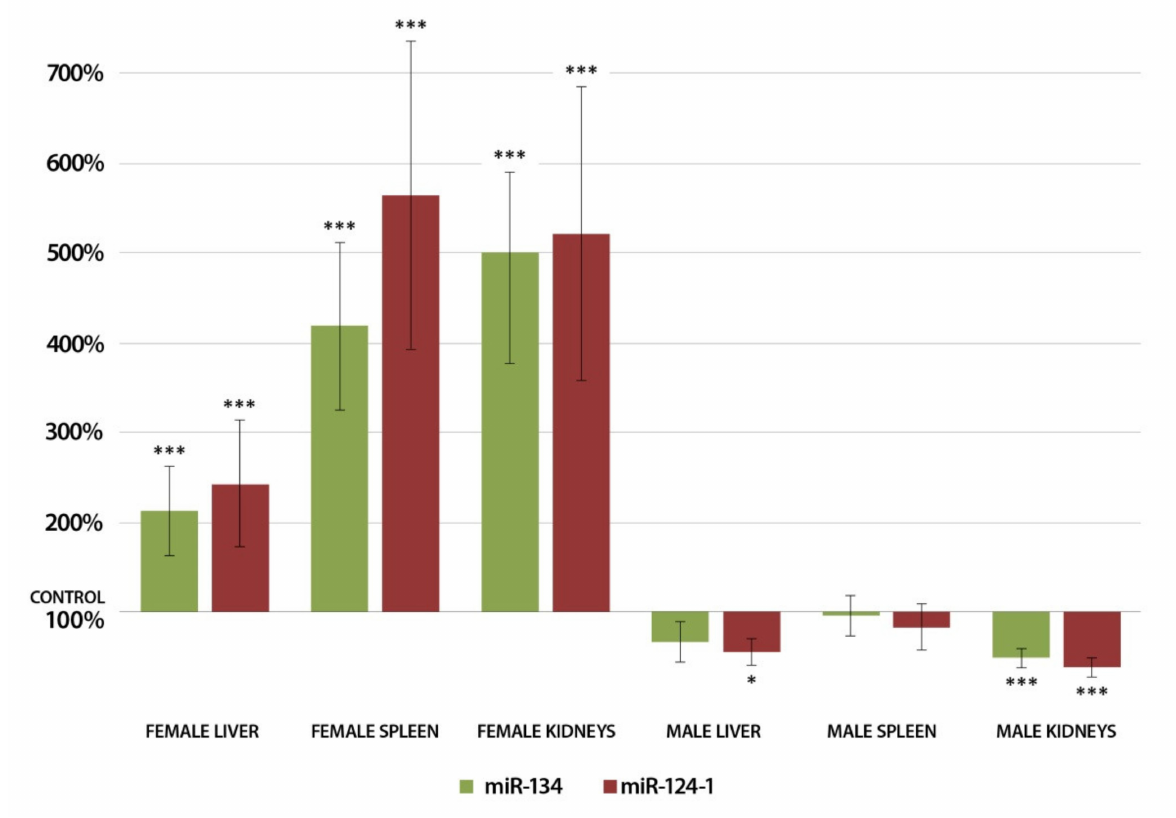
Figure 4. Expression results of miR-134 and miR-124-1 in the liver, kidneys, and spleen of CBA/Ca mice 24 h after DMBA treatment, compared to non-treated mice (100%) (* p < 0.05; *** p < 0.001). Considering the effects of sex-specific hormonal differences and the statistically signif- icant expressions of miR-134 in the examined organs, miR-134 was found to be a usable biomarker only in